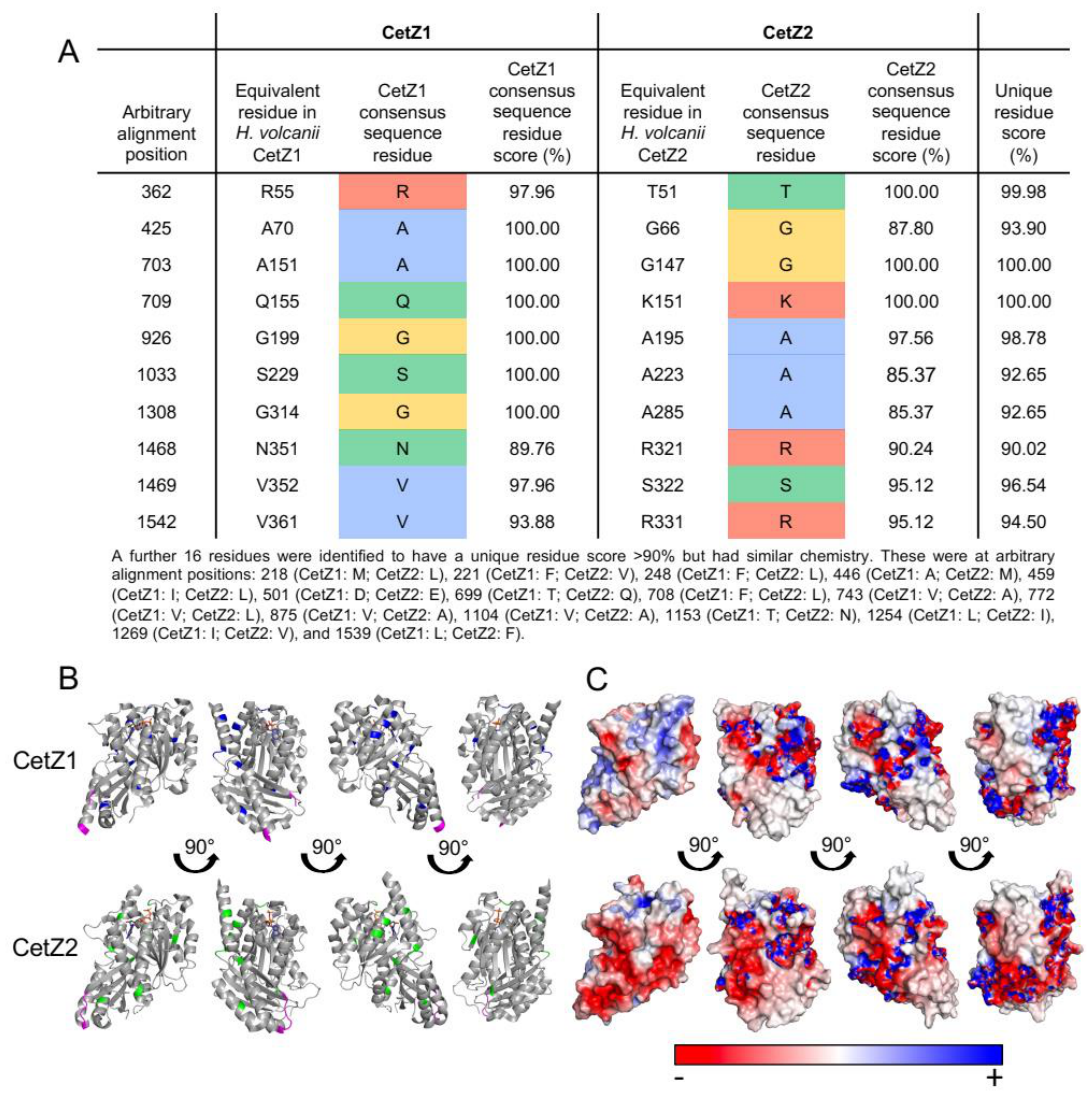
Figure 3. Characterising unique residues in CetZ1 and CetZ2 sub-families from Halobacteria. ( A ) Unique residues were defined as residues which had a unique residue score greater than 90%. The consensus sequence residue score and unique residue score were calculated as in Figure 2. Consensus residues are coloured according to their chemistry as in Figure 2A. ( B ) Three-dimensional structural comparison of crystal structures of GDP-bound CetZ1 (PDB: 4B46) and GTP-bound CetZ2 (PDB: 4B45) from H. volcanii . Residues that constitute the M-loop of CetZ1 and CetZ2 are represented in magenta. Unique residues listed in ( A ) are represented in blue for CetZ1 and green for CetZ2. ( C ) Surface electrostatics calculations for CetZ1 and CetZ2 are shown in the same respective orientations as in panel ( B